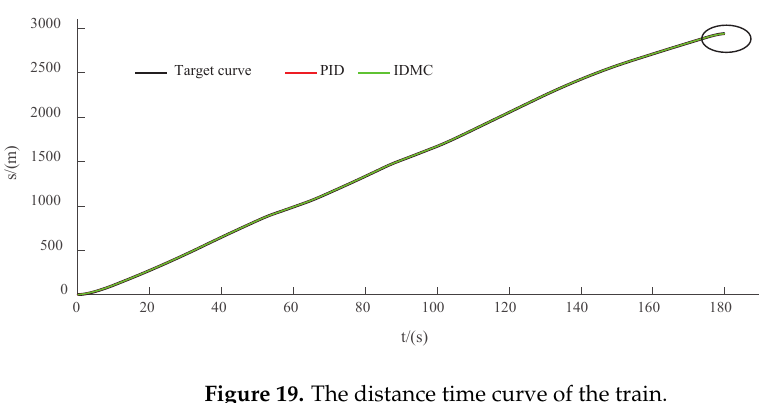
Figure 19. The distance time curve of the train.